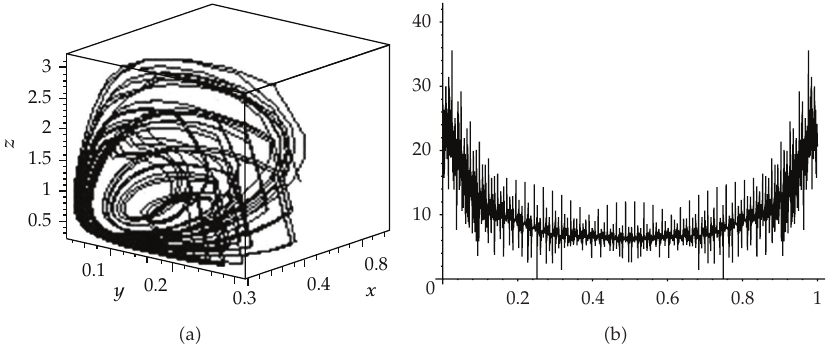
Figure 5: Strange attractor and power spectrum. (cid:5) a (cid:6) Strange attractor when p (cid:7) 1 . 25, (cid:5) b (cid:6) power spectrum of attractor (cid:5) a (cid:6)